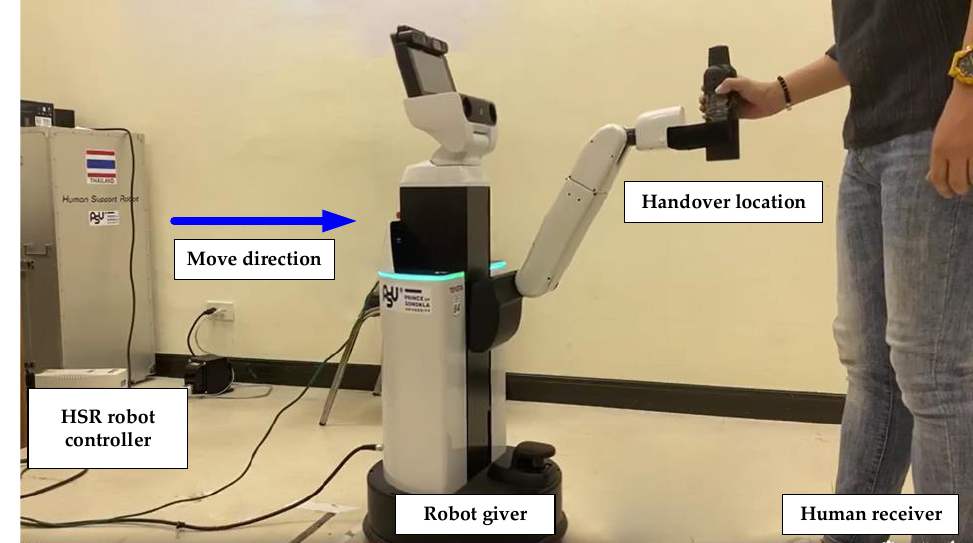
Figure 8. Experimental setup of the robot-to-human object handover system. Table 1. Comparisons of the average interactive force ( F int ) and time ( t ) parameters, while individually varying the damping factor ( B d ) and spring stiffness ( K d ),